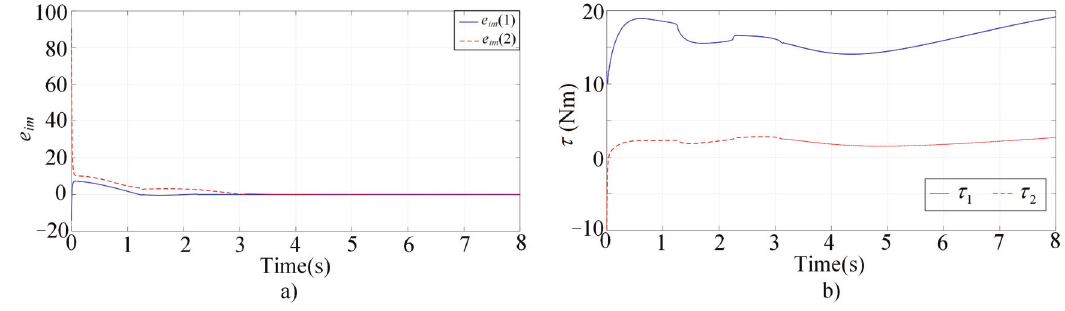
Figure 2. Simulation results of the multimodal controller in t ∈ [ 0,8 ) . ( a ) The impedance errors; ( b )The control